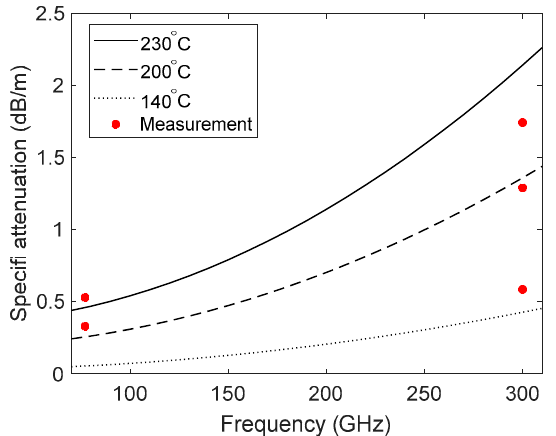
Figure 11. The calculated specific attenuation versus frequency in comparison with the measured data at 77 and 300 GHz.